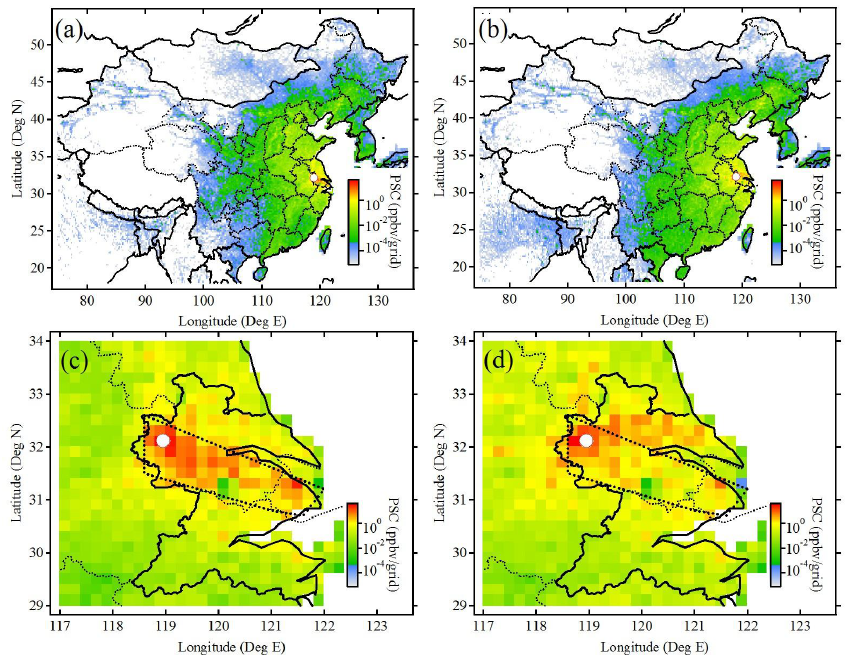
Figure 11 . ( a ) and ( b ) Averaged distributions of potential source contribution of CO for 2 Fig. 11. (a) and (b) are averaged distributions of potential source contribution of CO for episode days with O 3 exceedances and pre-/post- episode days, respectively. (c) and (d) are zoomed views of (a) and (b) , respectively. Note: the dashed line shows the mid-YRD area. episode days with O 3 exceedances and pre-/post- episode days, respectively. ( c ) And ( d ) a 3 zoomed view for 11( a ) and 11( b ), respectively. Note: The dashed line show the mid-YRD 4 area. 5